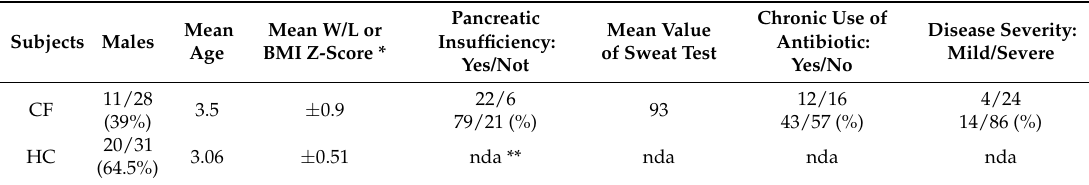
Table 1. Cystic fibrosis (CF) Patients and healthy controls (HC)